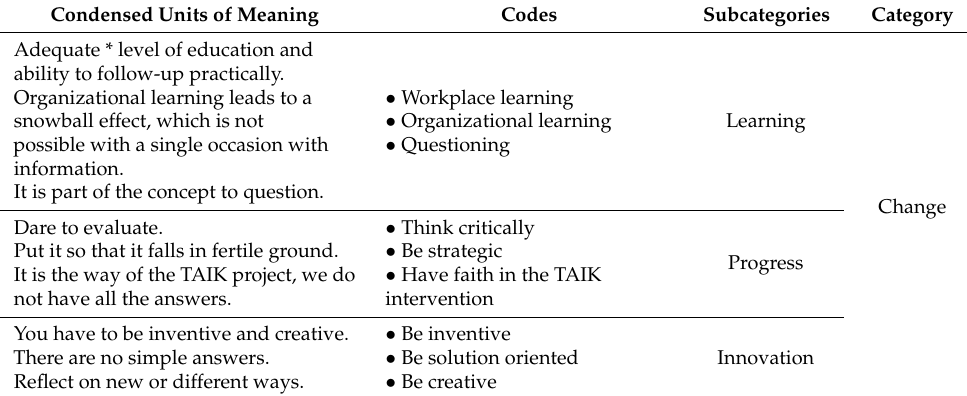
Table 3. Summary from the analysis regarding the category “Change”.